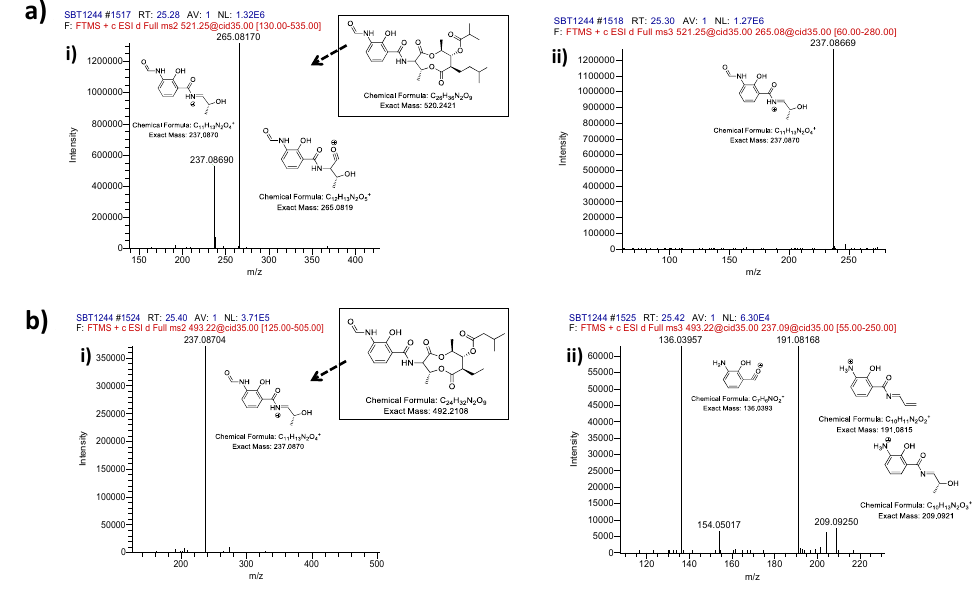
Figure 6. Fragmentation of parent ions that were tentatively assigned as antimycins showing fragmentation of ( a ) parent ion m/z m/z 521.24854 (Antimycin A3 or A7, C 26 H 36 N 2 O 9 ) and ( b ) parent ion m/z 493.21734 (Antimycin A5, C 24 H 32 N 2 O 9 ). MS 2 spectra ( i ) and MS 3 ( ii ) are annotated to illustrate the predicted fragmentation patterns of parent antimycins.